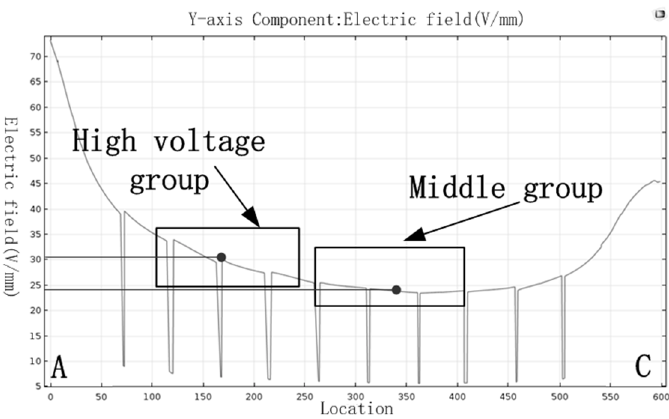
Figure 9. Y axis component of electric field.